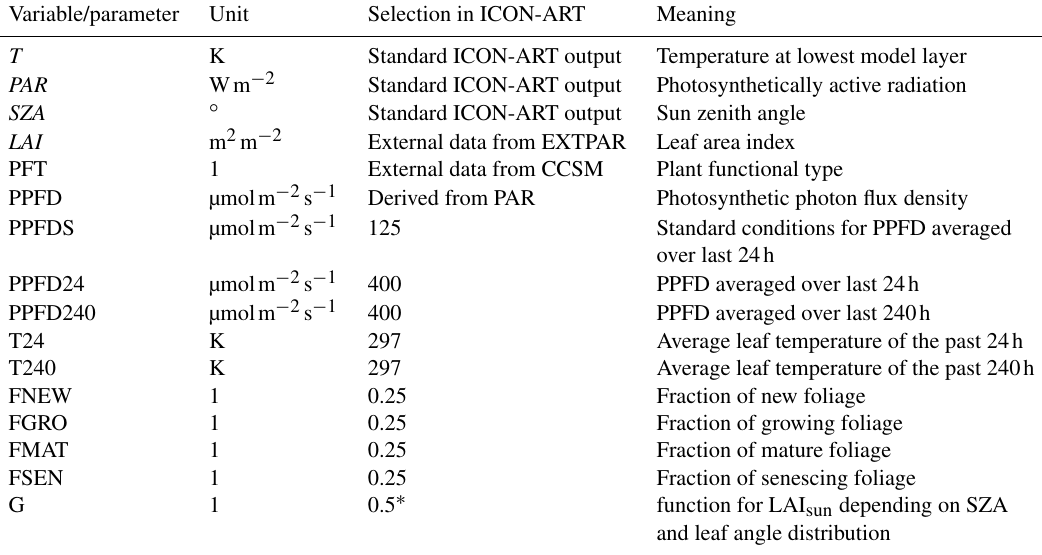
function for LAI sun depending on SZA and leaf angle distribution